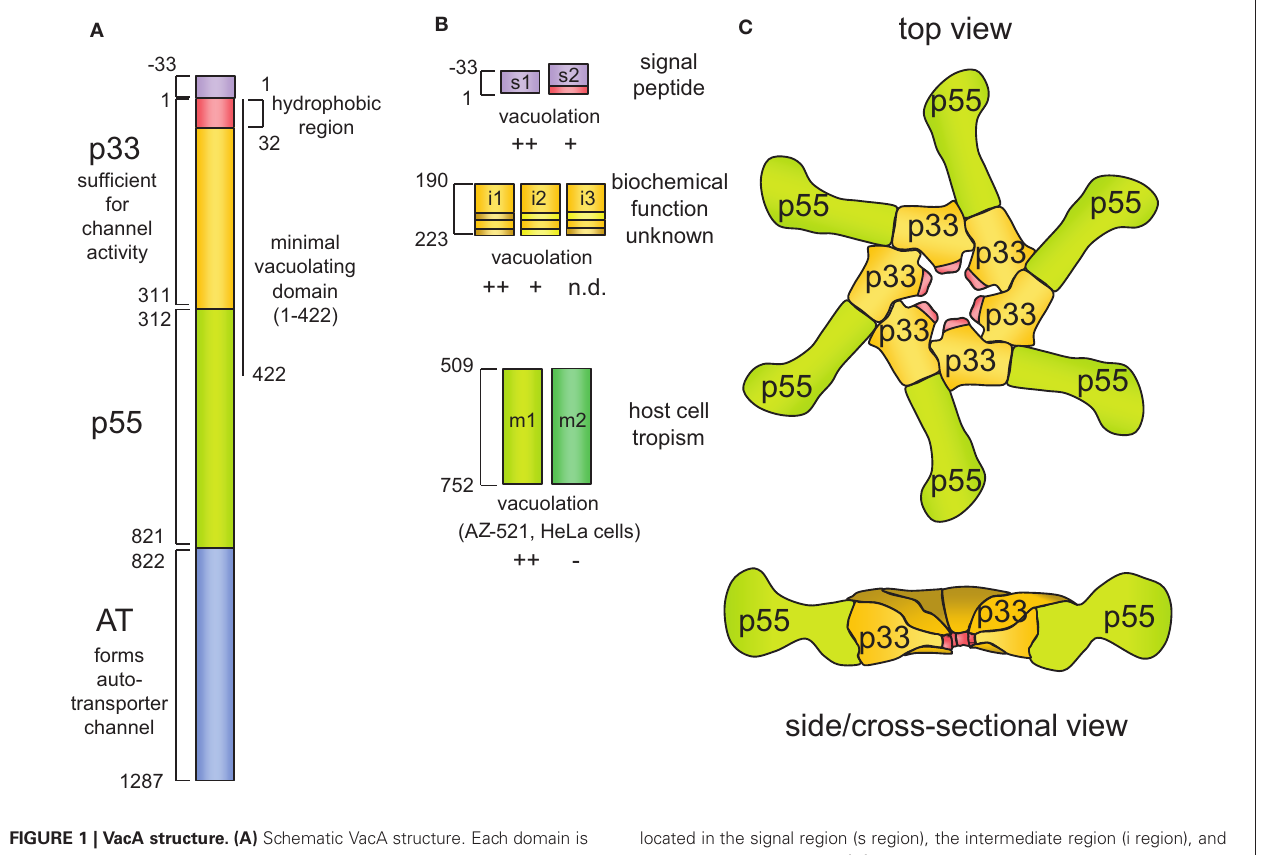
located in the signal region (s region), the intermediate region (i region), and the mid-region (m region). (C) The proposed structure of the VacA oligomeric assembly, based on the crystal structure of a portion of p55 [Gangwer et al. (2007)] and electron microscopy imaging of VacA oligomers [El-Bez et al.